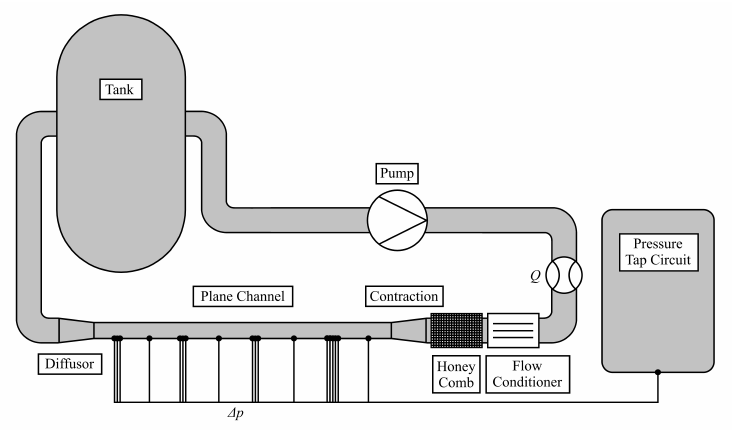
Figure 4. Setup for the rough channel flow experiments.